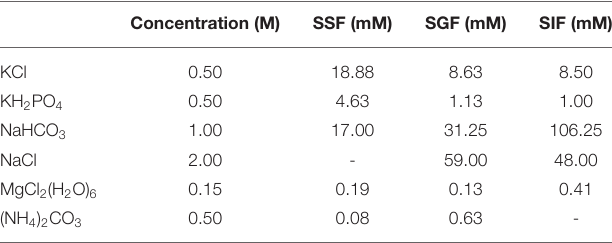
TABLE 1 | Preparation of stock solution of simulated digestion